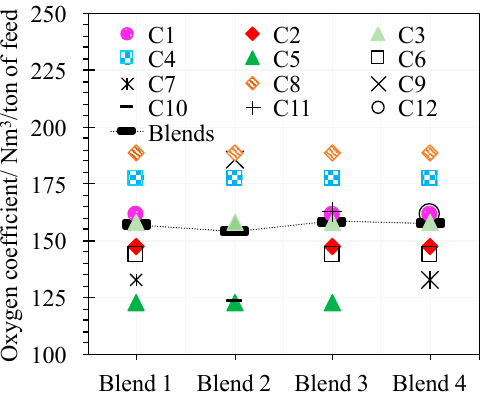
Figure 6. Modeling results of the oxygen coefficient needed for smelting blends and concentrates under the same conditions. In the same column, the parameter values for the blend (black) and the concentrates that compose it appears.